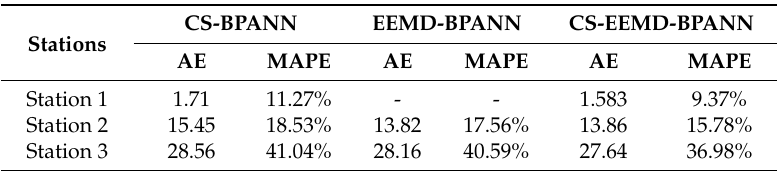
Table 19. The performance of forecast